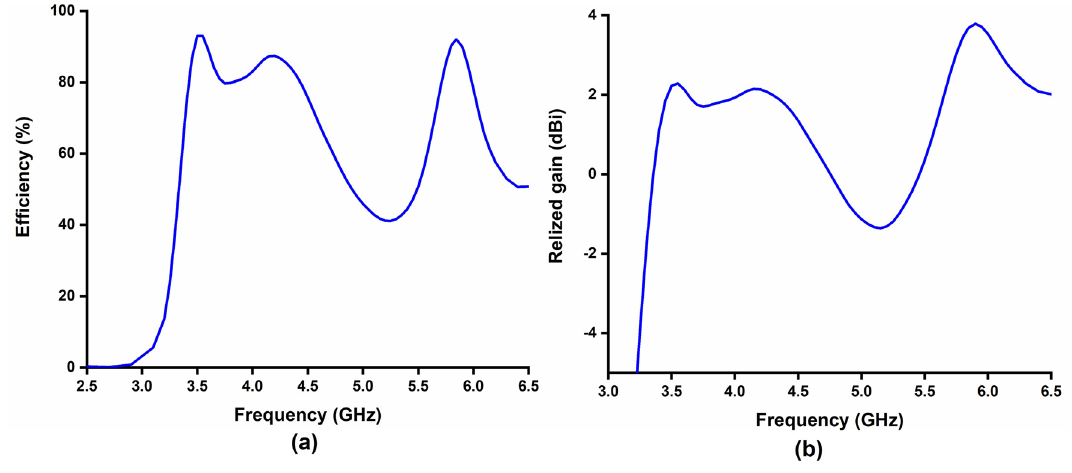
Figure 17. ( a ) Simulated Efficiency; ( b ) realized